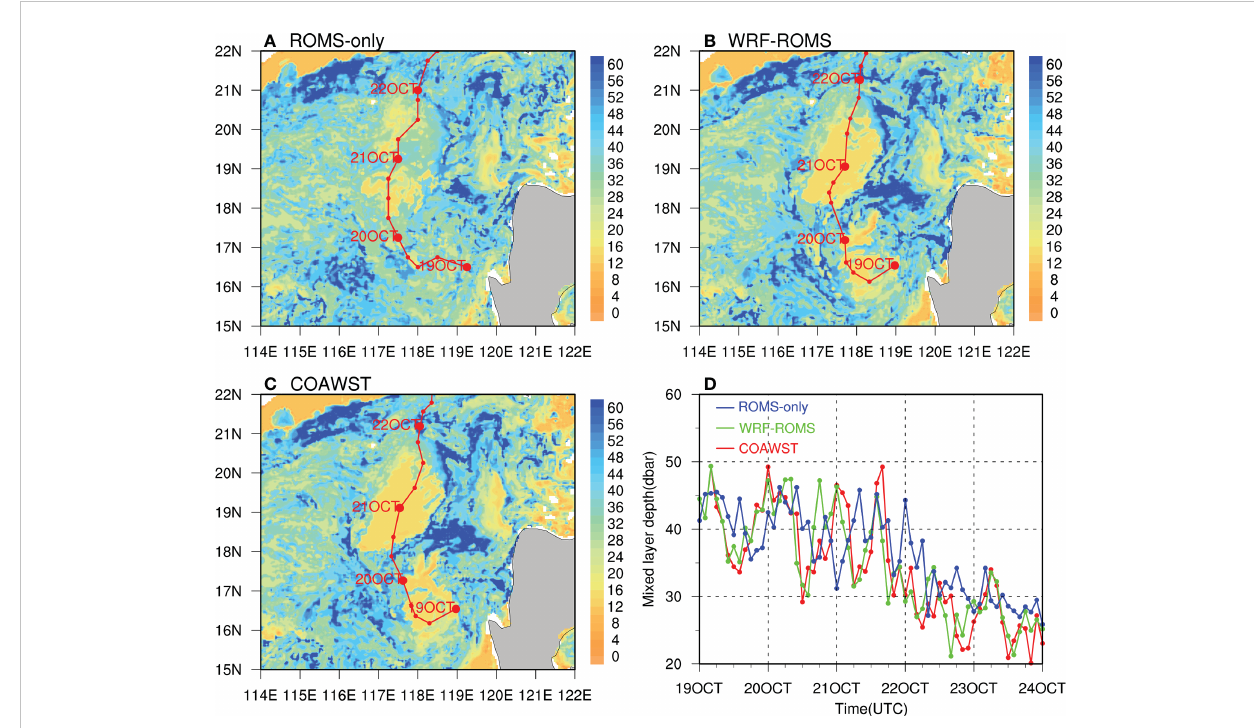
FIGURE 6 Simulated density mixed layer depth (dbar) of experiments at 00 UTC 22 Oct for (A) ROMS-only, (B) WRF-ROMS, and (C) COAWST. The track (solid red line) in (A) is derived from ERA5 reanalysis, (B) is from WRF-ROMS simulation, and (C) is from COAWST simulation. (D) Comparison of the changes of density mixed layer depth, the average value in the region 50 – 150 km away from the TC center at 00 UTC 22 Oct